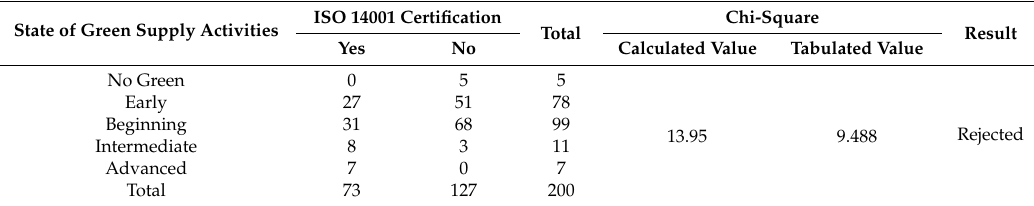
Table 5. Chi-square test results to measure the association between the state of the green supply chain management process and ISO 14001 certification achieved by an organization.